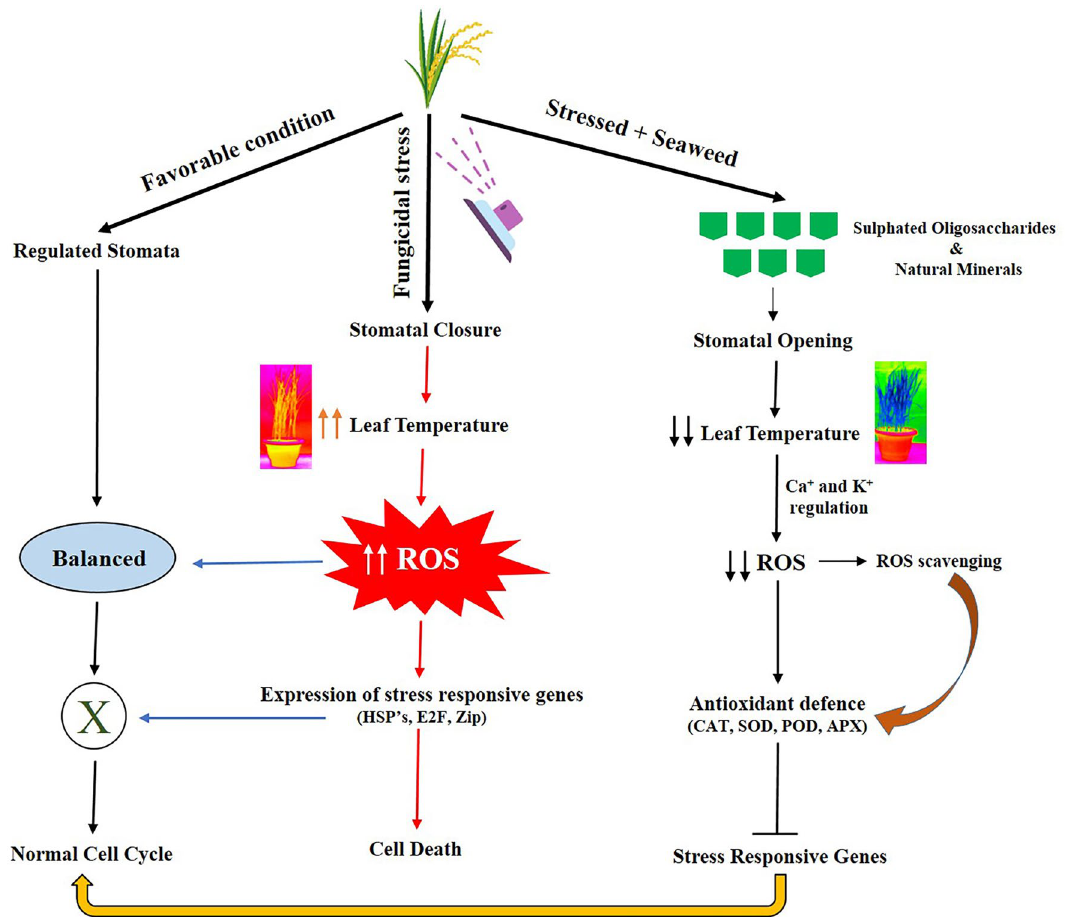
Figure 8. Schematic representation depicting the mechanism of red seaweed biostimulants in imparting fungicidal stress Plant growth and stress induction in the glasshouse. In this study, we have used a cultivated popular rice variety i.e., cv. IR-64 which was grown under glasshouse conditions at the Glass House Facility, Depart- ment of Plant Pathology, University of Agricultural Sciences (UASB), Gandhi Krishi Vignan Kendra (GKVK), Bangalore, India. The glasshouse studies and experimental research including the collection of plant material, complied with institutional, national and international guidelines and legislation. This plant species has not been listed as endangered and the collection sites of this study were not inside the national park or other restricted forest areas. The experiments were carried out in controlled conditions. Thirty days old plants were subjected to different treatment viz., T 1 : tricyclazole 75%WP (0.6 g L -1 ), T 2 : carbendazim 50%WP (1.0 g L -1 ), T 3 : LBS6 20% (1 mL L -1 ), T